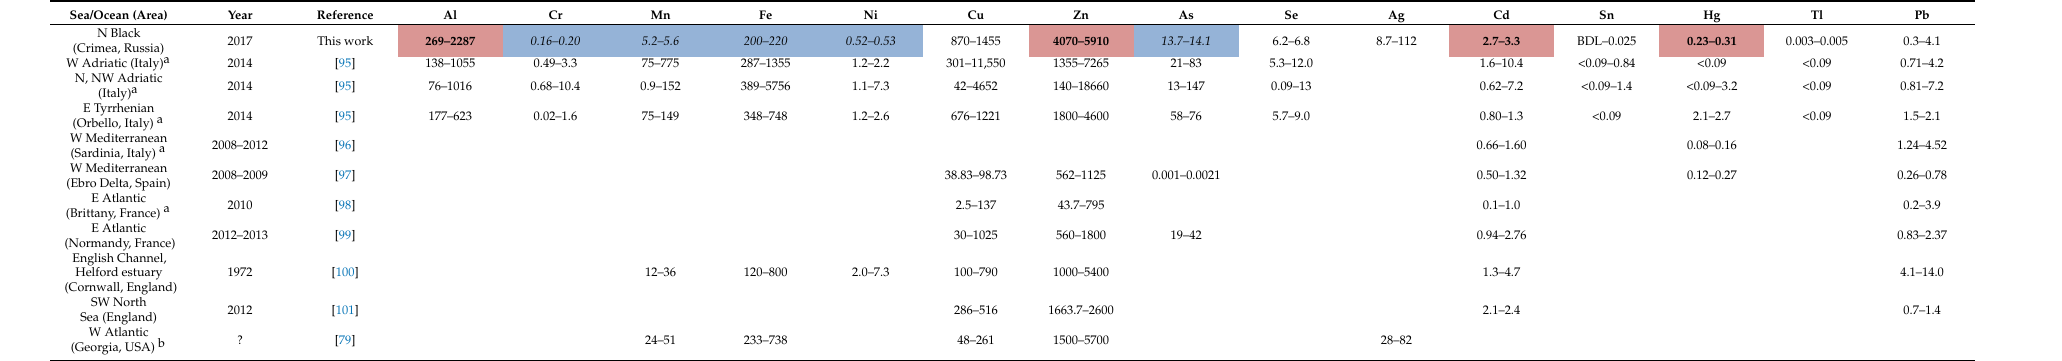
Table 7. Element contents (min–max) in soft tissues of the oyster Crassostrea gigas collected in different areas of the Atlantic basin. Notations, emphases and shadings mean the same as in Table